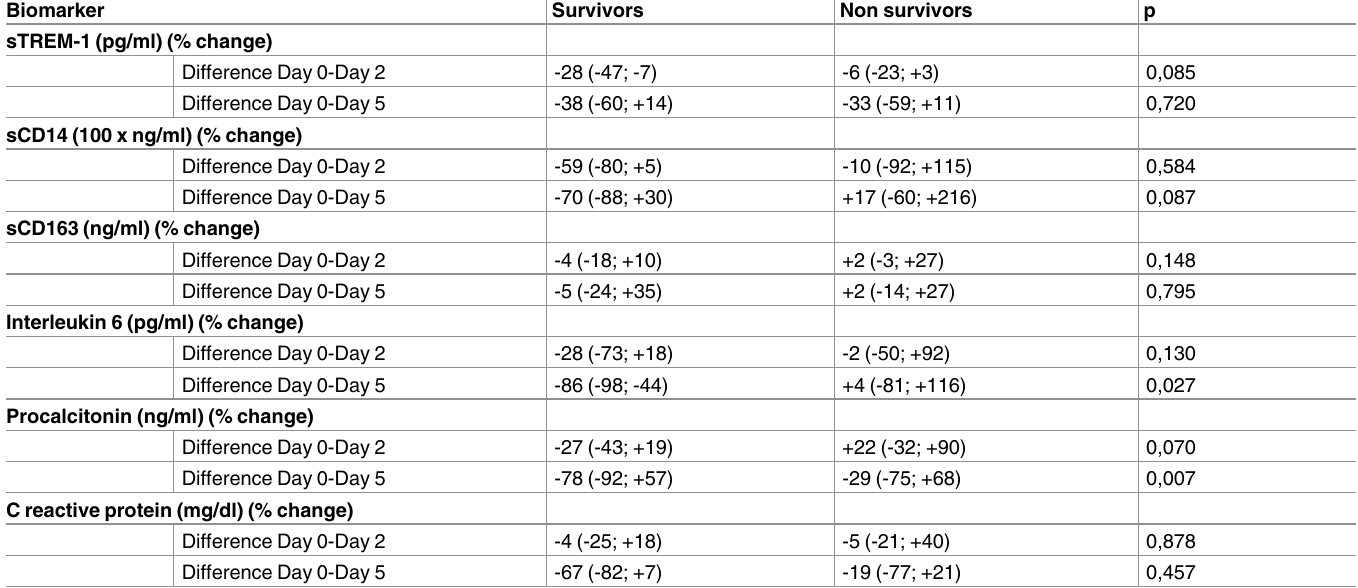
Table 5. Changes in serum levels of biomarkers during the first 5 days of intensive care unit stay in patients who survive and those who died with severesepsis/septic shock.